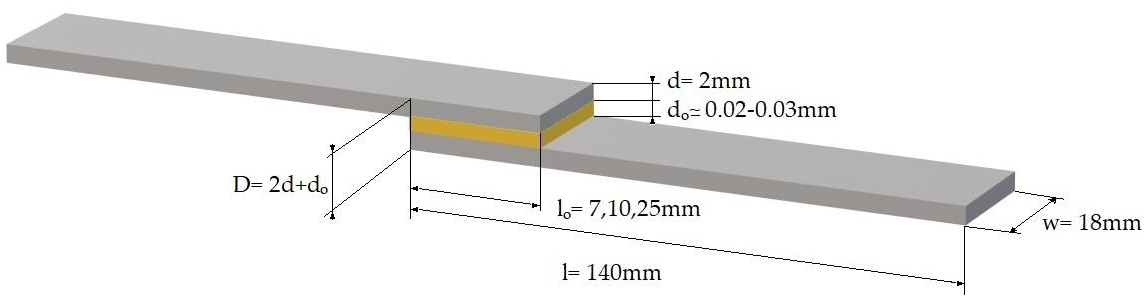
Figure 1. Single-lap joint specimen.